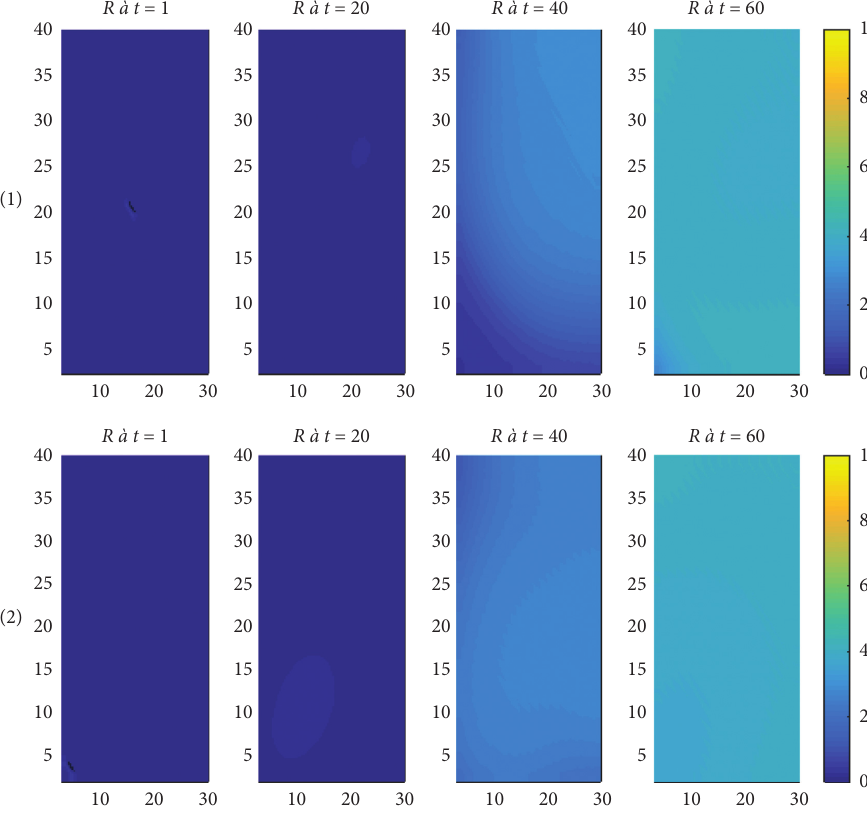
Figure 7: Recovered behavior within Ω with control (vaccine strategy after 30 days).